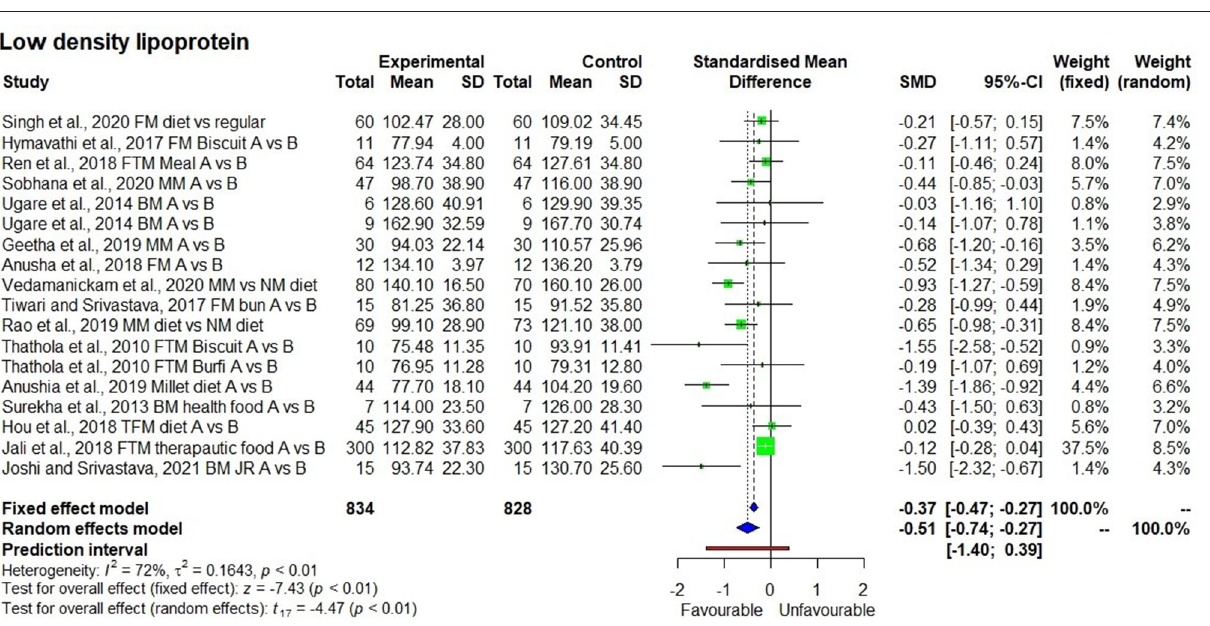
to − 0.19, and I 2 value of 89% confirming the heterogeneity ( Figure 2 ). Descriptive statistics conducted for 870 samples, and 21 observations from the 18 studies showed that the TC levels decreased by 8% from 189.5 ± 27.7 to 174.8 ± 28.9 mg/dl.